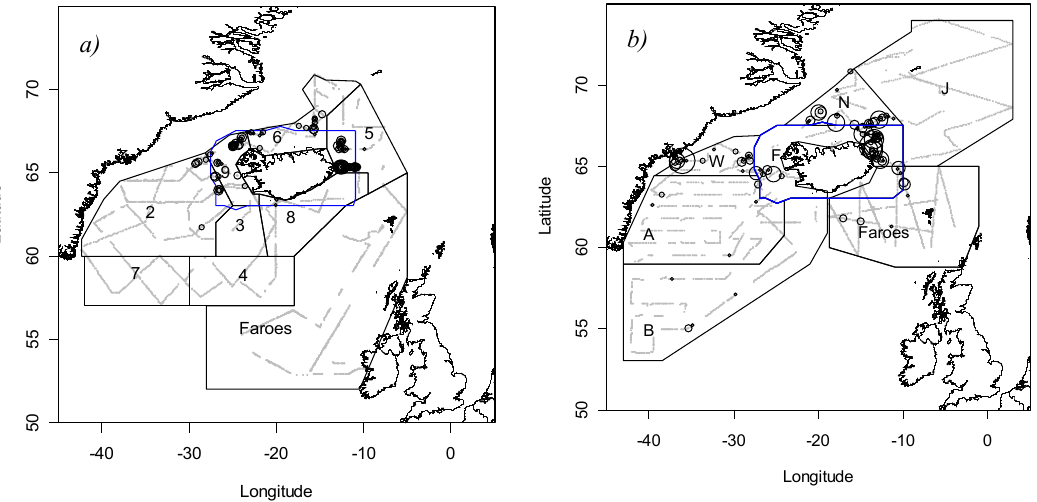
Fig. 2. The realised shipboard survey effort (grey lines) and location of sightings (circles) for a) 1995 and b) 2001. Observed pod sizes are proportional to the area of the circles. Black lines indicate the ship survey blocks and the blue lines indicate the aerial survey